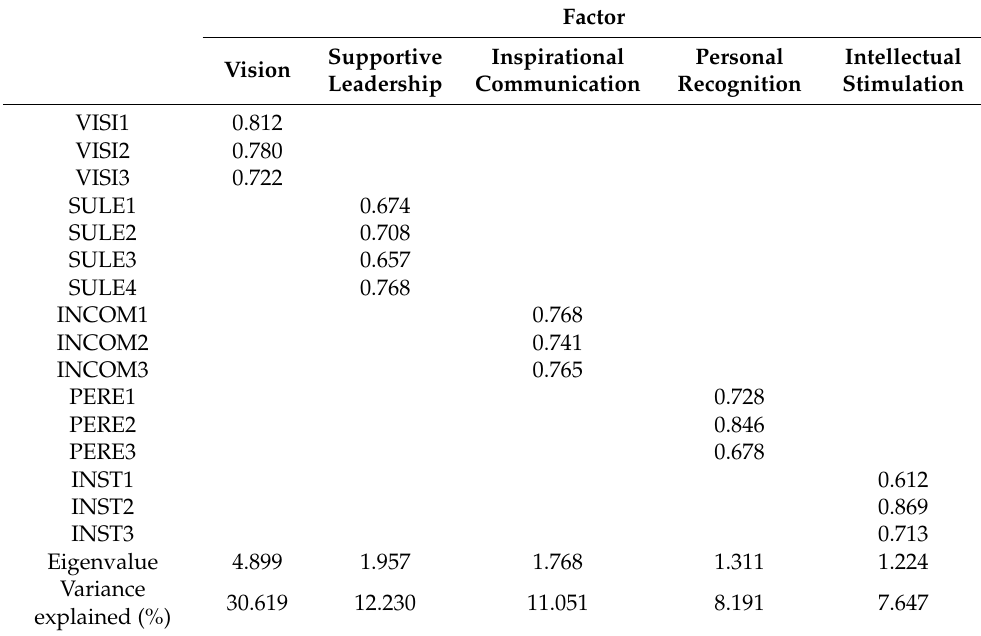
Table 4. Transformation leadership factor